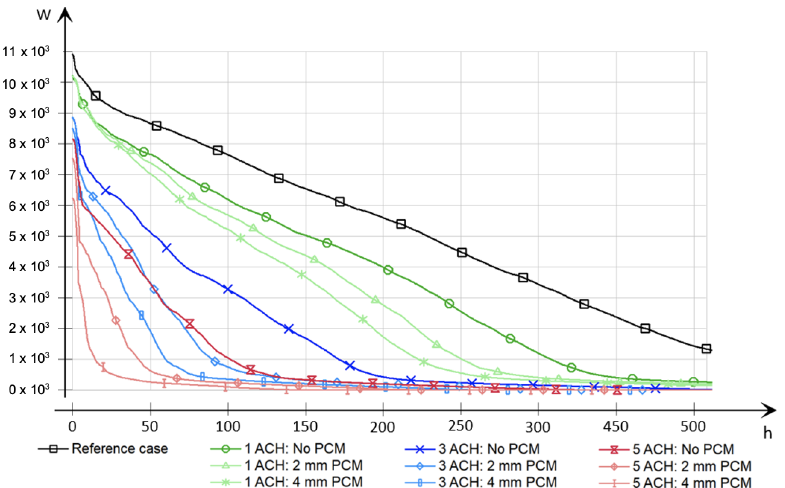
Figure 9. Cooling load duration diagram for the whole building. Cases of 1, 3 and 5 ACH with and without PCM are compared to the reference